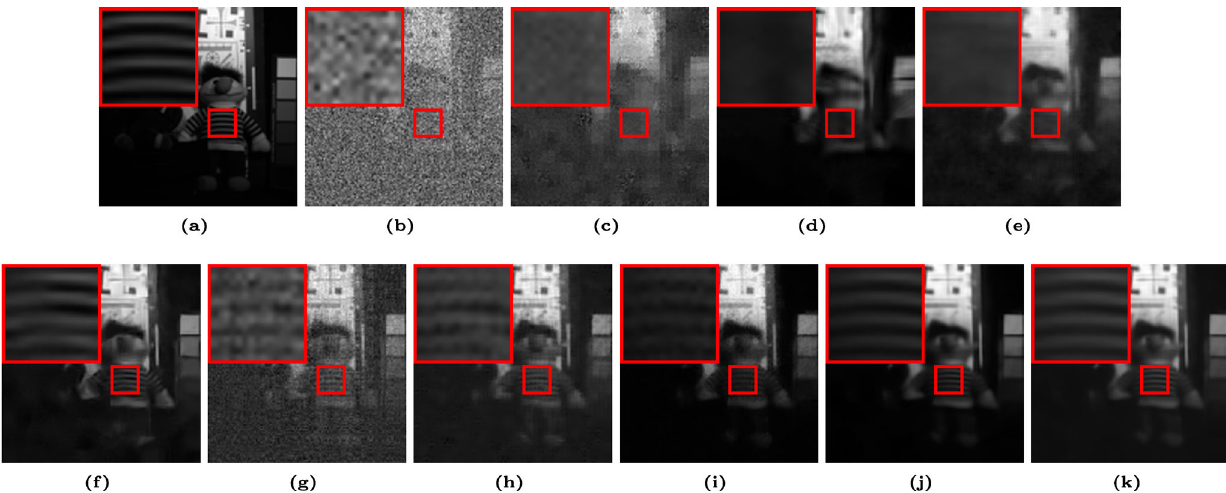
Fig. 3 Denoising results for one band of chart and stuffed toy using different methods. (a) Original image; (b) noisy image, variance = 0 . 30; (c) BW K-SVD [6]; (d) BW BM3D [7]; (e) ANLM3D [24]; (f) BM4D [13]; (g) PARAFAC [12]; (h) TDL [14]; (i) t-SVD [27]; (j) KBR [16]; (k)